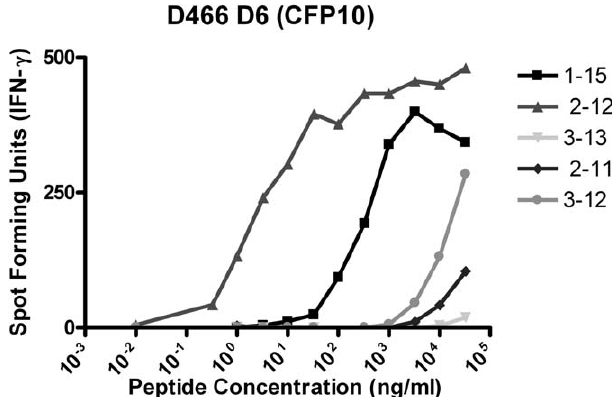
Figure 4. Confirmation of Minimal Epitope Mapping of D466 D6 To confirm the minimal epitope, autologous LCLs (20,000/well) were pulsed with peptide at the concentration indicated and co-cultured with T cells (1,000 cells/well). IFN- c was assessed by ELISPOT after 18 h co- culture. Each point represents the mean of duplicate